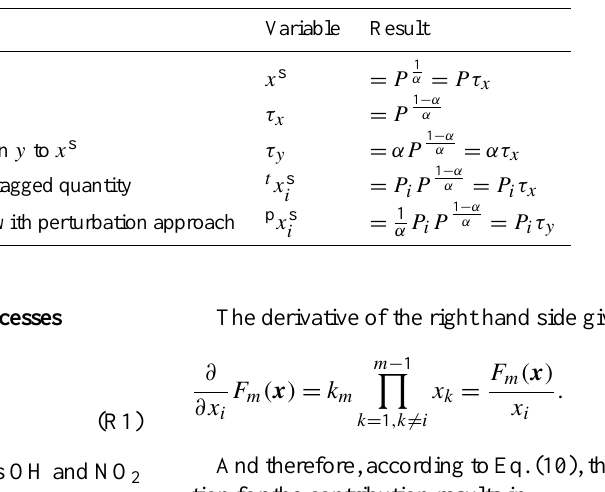
Table 2. Overview on the characteristics of the non-linear system ˙ x = P − x α . See Sect. 5 for